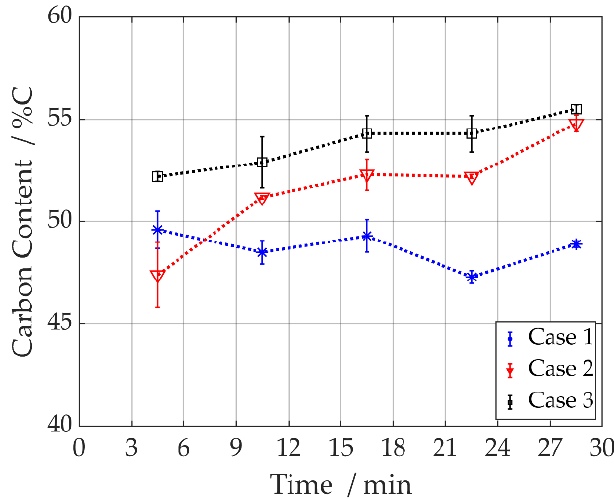
12 of 18 Figure 7. Centrate particle size distributions for the three cases over time. Blue: 20,000 rpm; Red: 40,000 rpm; Black: Increasing rotational speed. ( a ) Characteristic particle sizes, squares: 𝑥 10 ; triangles: 𝑥 50 with dashed lines as guides to the eye; stars: 𝑥 90 . ( b – d ) Detailed particle size distributions for the